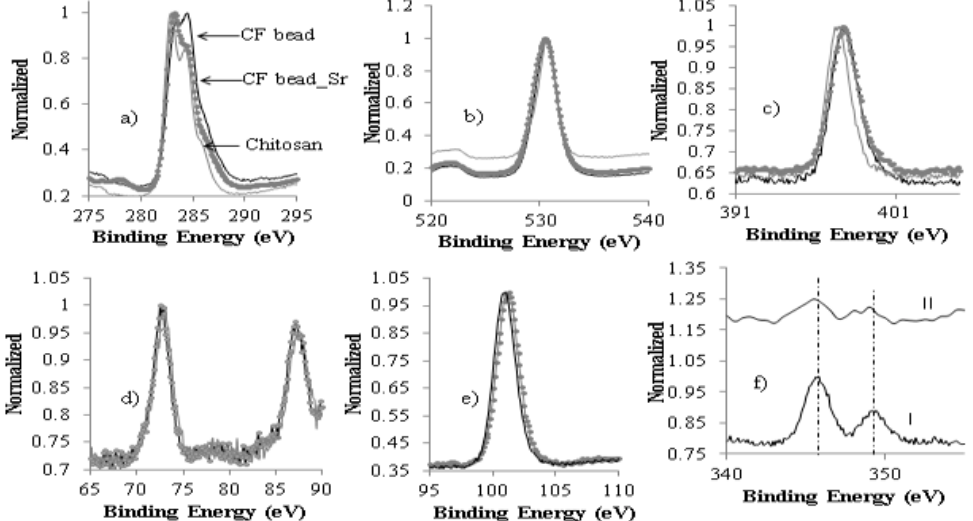
Figure 7. X-ray photoelectron spectroscopy (XPS) spectra of ( a ) C-1s, ( b ) O-1s, and ( c ) N-1s for the chitosan flake, CF bead, and the CF beads following exposure to strontium solution and of ( d ) Al-2p, and ( e ) Si-2p and ( f ) Ca-2p that present in the CF bead (i) before and (ii) after exposure to strontium